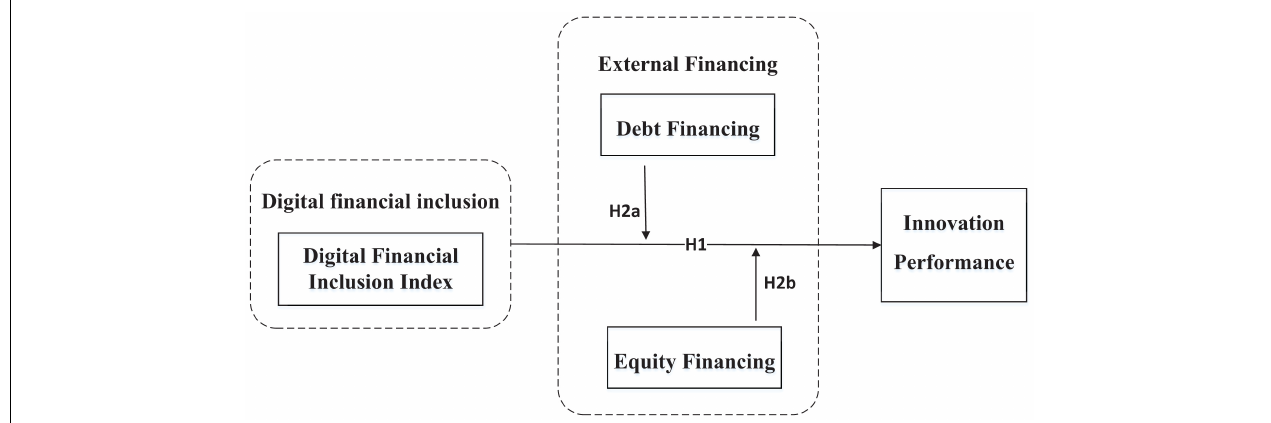
FIGURE 1 | Theoretical model